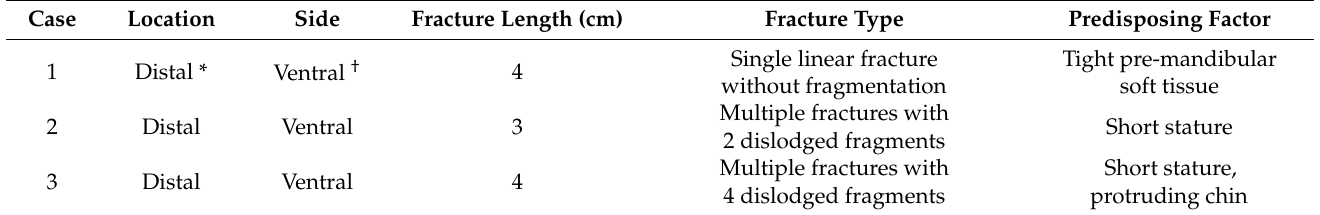
Table 2. Patterns of cannula